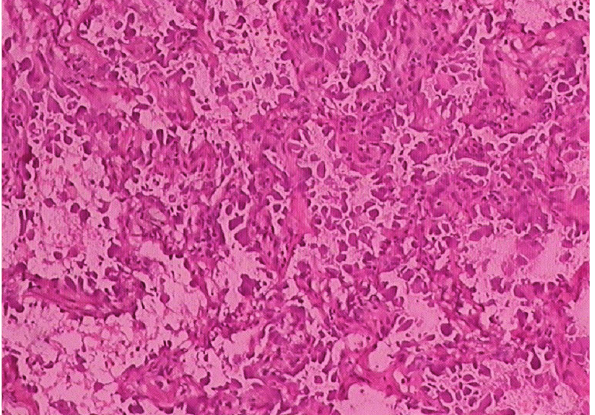
Figure 1: Histopathologic examination of formalin-fixed and paraffin- embedded tumor tissue with BRAF Thr599dup gene mutation.